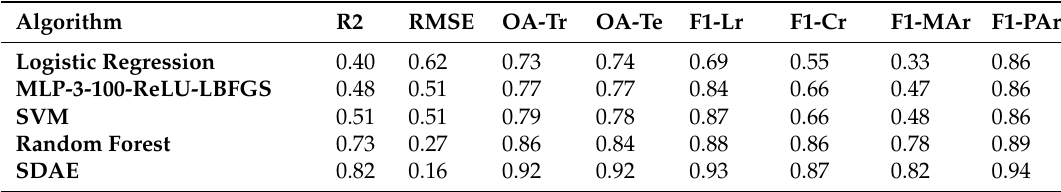
Table 3. Classification results for Isfahan.